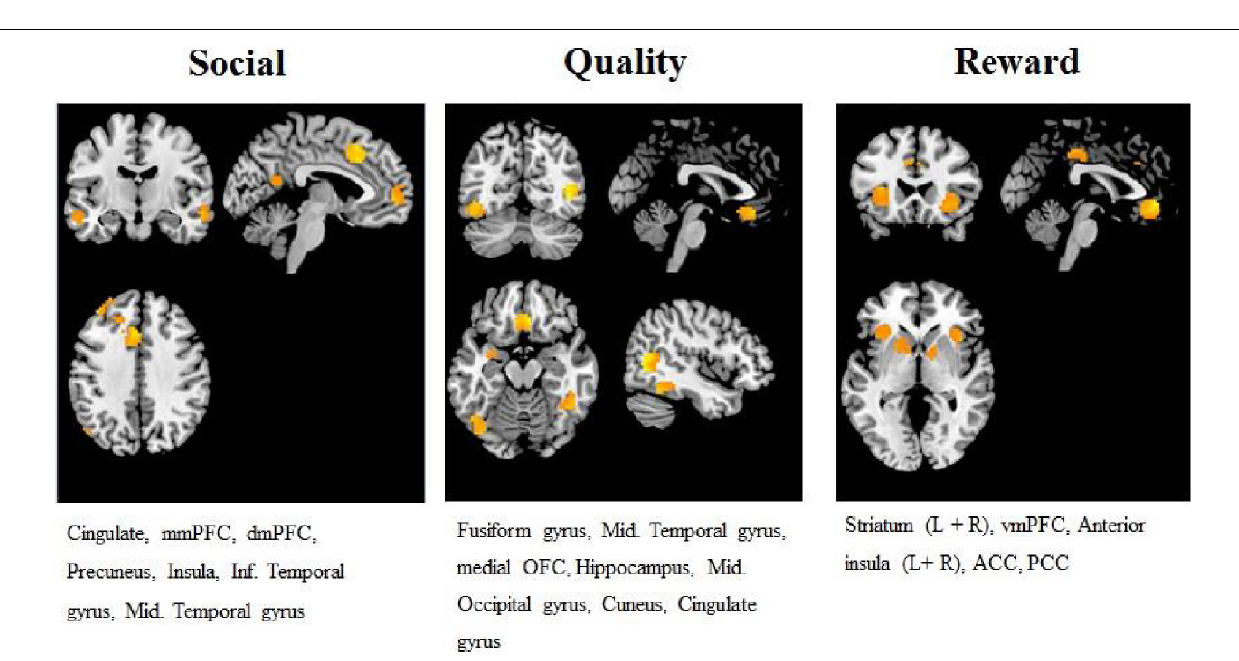
Frontiers in Psychology |